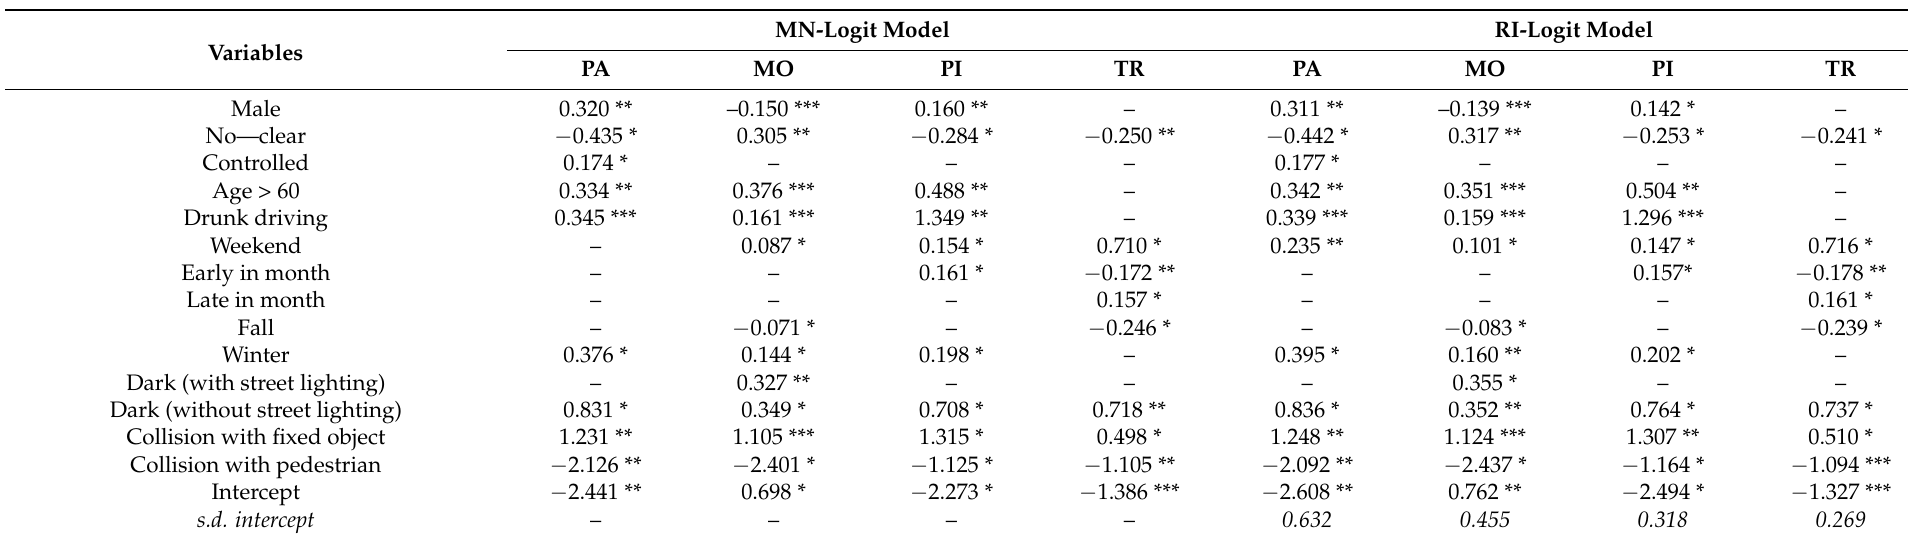
Table 4. Estimation of the parameters of the MN-logit model and the RI-logit